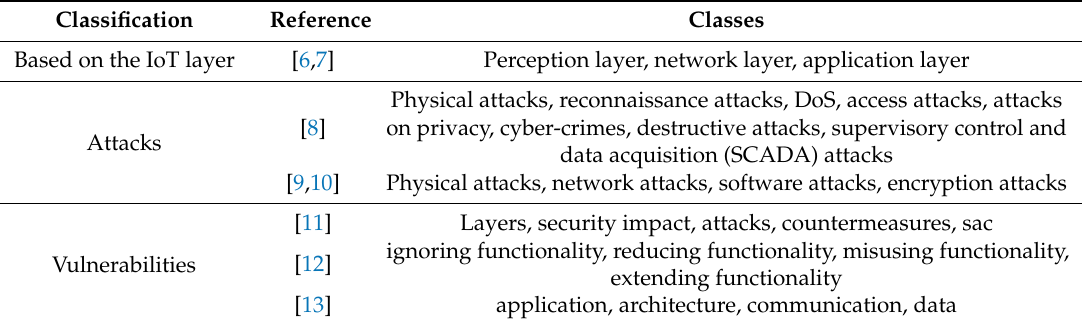
Table 1. Summary of classification